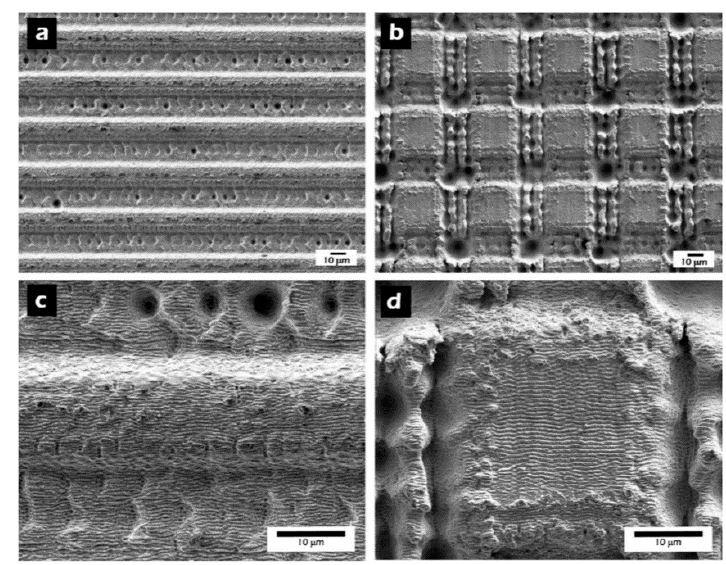
Figure 7. SEM micrographs of hierarchical structures fabricated on stainless steel: ( a ) trench micro pattern with a pitch distance of 30 µm; and ( b ) matrix micro pattern with a pitch distance of 50 µm both covered by LIPSS. Detailed area scanned on: ( c ) trench micro pattern; ( d ) matrix micro pattern. Reprinted from Martínez-Calderon et al . [47], Copyright 2015, with permission from Elsevier.